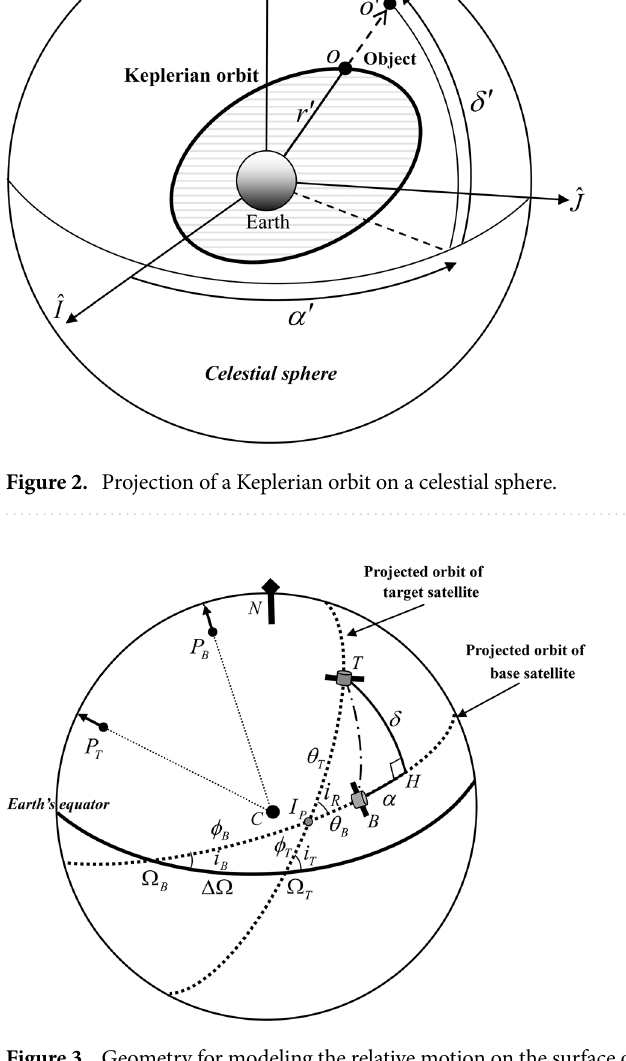
Figure 3. Geometry for modeling the relative motion on the surface of a